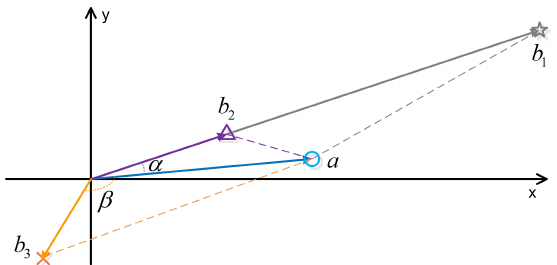
Figure A2. Taking a two-dimensional space as an example, count the metrics from b 1 , b 2 , and b 2 to a , respectively. The Cosine metric cannot reflect the difference between b 1 and b 2 for a . The L2 metric cannot reflect the difference between b 1 and b 3 for a .